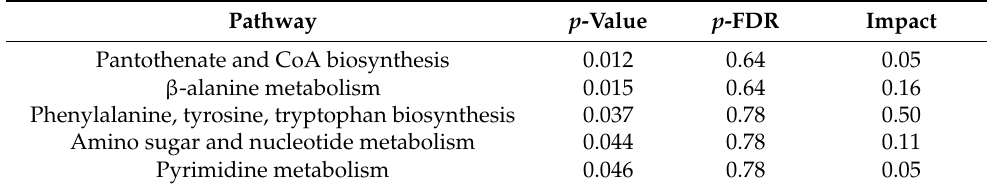
Table 3. Significant metabolic pathways involved in noise-induced hearing loss via perilymph analysis. The p -value was calculated from the enrichment analysis. p -FDR is the adjusted p -value using the false discovery rate. Impact values were calculated from the path topology analysis.